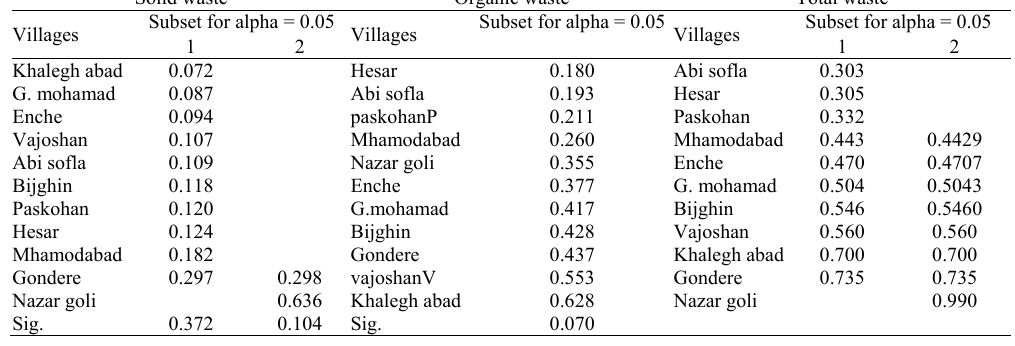
Table 2: Comparison of average household waste generation in the villages Solid waste Organic waste Total waste Subset for alpha = 0.05 Subset for alpha = 0.05 Subset for alpha = 0.05 Villages Villages Villages 1